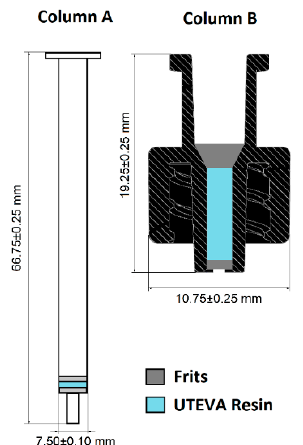
Figure 1. Schematic representation of the columns used for purification. Column A is a 1.5 mL, dual fritted filtration polypropylene cartridge. Column B is fabricated from a female-to-male Luer closure drilled in the male end cap with a 0.5 mm drill bit. Both columns were loaded with 20 mg of UTEVA resin as described previously [36].